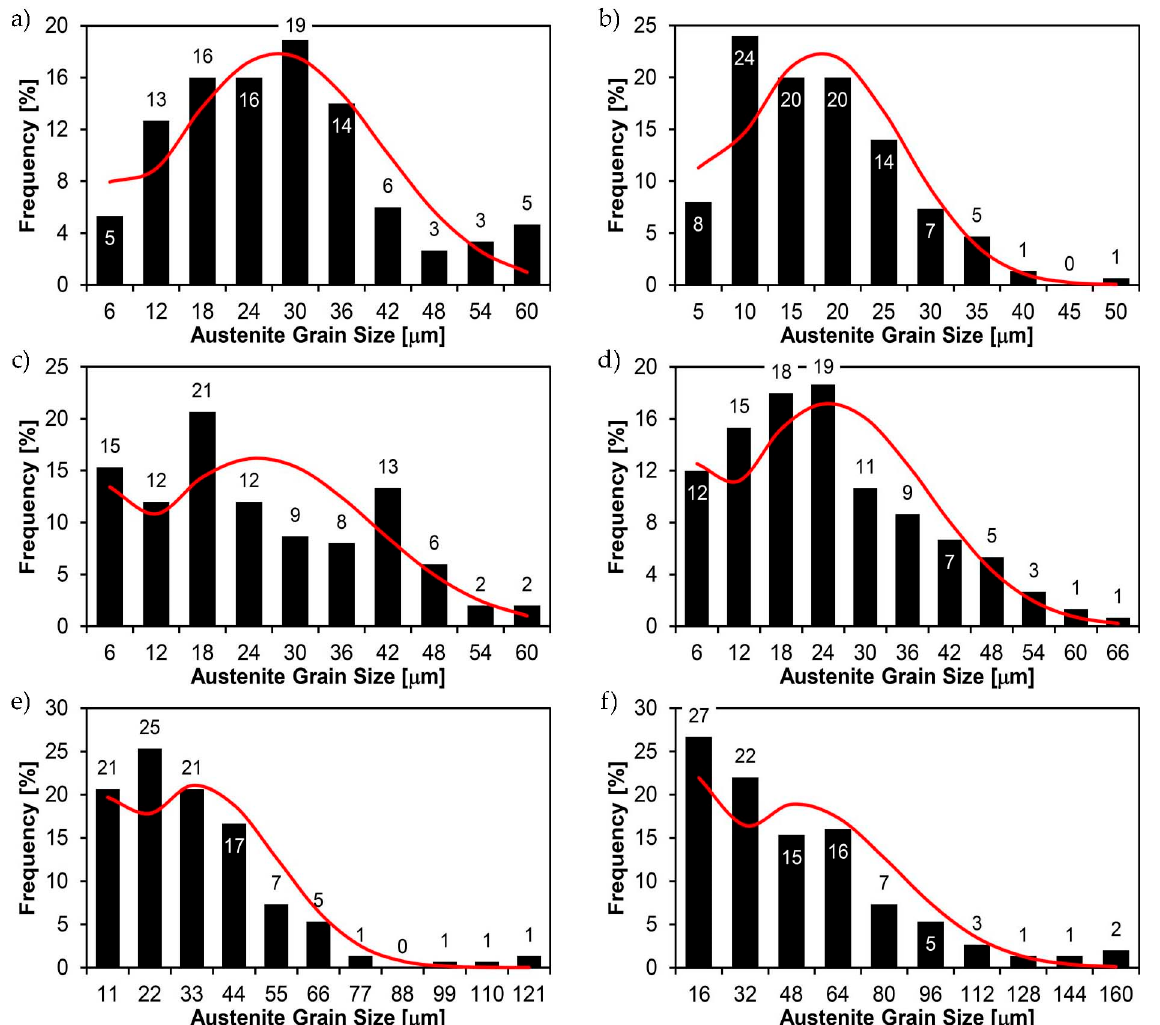
Figure 28. Frequency intervals and normal occurrence distributions of the determined grain sizes of prior austenite in the welded joint zone of Hardox 450 steel marked as BM in Figure 2: ( a ) normalised state; ( b ) delivery state (directly after welding); ( c ) after austenitising at 900 °C for 60 min; ( d ) after austenitising at 1000 °C for 60 min; ( e ) after austenitising at 1100 °C for 120 min; ( f ) after austenitising at 1200 °C for 120 min.